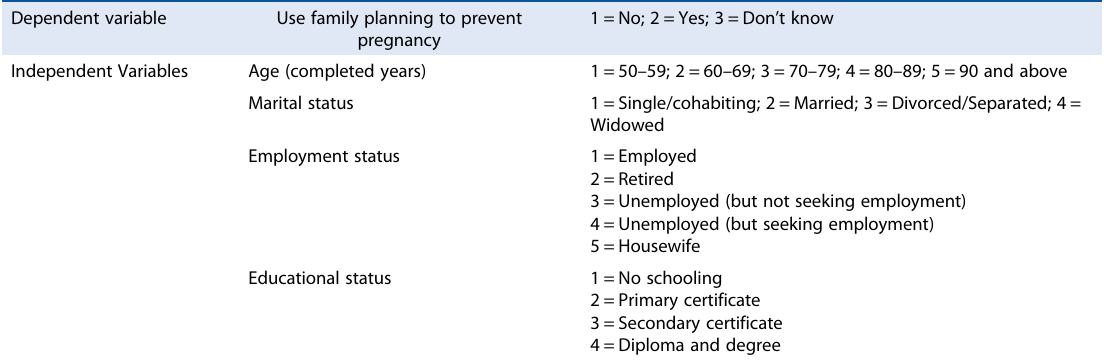
Table 3: Description of variables for multinomial logistic regression analysis Dependent